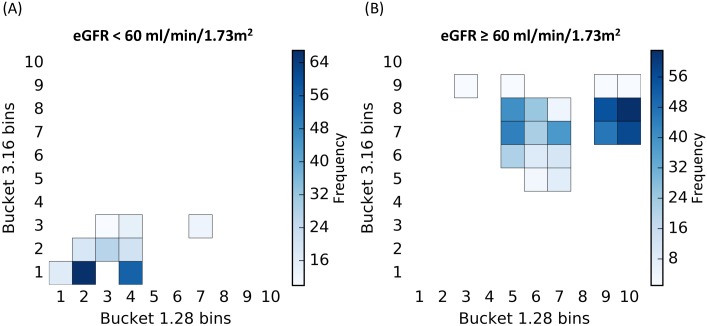
2D rules implicated in the interaction between buckets 1.28 (3-hydroxyisovalerate) and 3.16 (dimethylsulfone).The 2D rules are represented with their variable conditions, i.e., ranges of buckets bins for the buckets 1.28 (3-hydroxyisovalerate) (x-axis) and 3.16 (dimethylsulfone) (y-axis) and their frequency over the 100 models (color scale). The most frequent the bucket bin is covered by the 2D rules, the darker it will be. (A) shows the rules corresponding to the subgroup of patients with an eGFR < 60 ml/min/1.73m2 and conversely, (B) shows the rules corresponding to the subgroup of patients with an eGFR ≥ 60 ml/min/1.73m2.